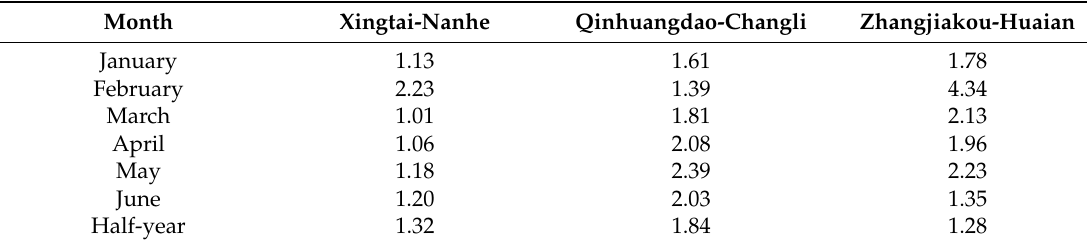
Table 2. Hygroscopic growth ability of f ( 80% ) at Xingtai-Nanhe, Qinhuangdao-Changli, and Zhangjiankou-Huaian. Month